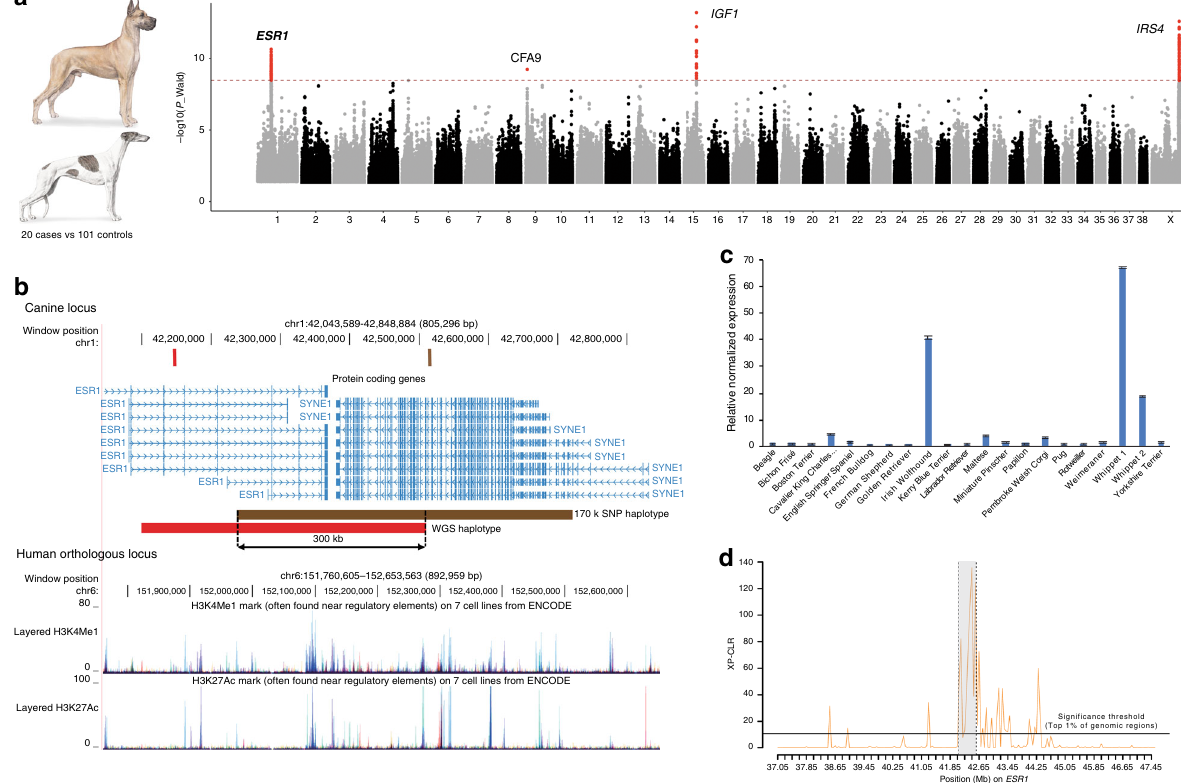
Fig. 4 ESR1 and the long leg phenotype in dogs. a Manhattan plots showing statistical signi fi cance ( − log10 scale) for the 30,000 most associated biallelic variants for each canine autosome, and all variants for the X chromosome ( X -axis) for the long-leg phenotype observed in Sighthounds, Great Dane, and Great Pyrenees. We distinguish four peaks: one peak pinpointing ESR1 gene on chromosome 1, one locus on CFA9 without any candidate genes in the interval, and IGF1 (CFA15) and IRS4 (CFAX) previously associated with height variation in dogs. Images to the left are Great Dane (top) and Greyhound (bottom). b UCSC genome browser showing the ESR1 locus in dog (top) and human (bottom). Vertical bars correspond to the most associated variants identi fi ed with the 722 genomes (in red), and the 855 dogs genotyped on 170k SNP array (in brown), and horizontal bars represent the homozygous haplotype observed. The bottom panel represents the human orthologous locus with tracks corresponding to the H3K4me1 and H3K27ac chromatin signals annotated by the ENCODE project 55 . c Expression level of ESR1 in a panel of 20 breeds, showing high expression in the Sighthounds, Irish Wolfhound and Whippet, in comparison to six different breeds with average leg length. Y -axis represents the relative normalized expression. d XP-CLR plot on ESR1 locus comparing Sighthounds (long legs breeds) with normal-sized legs breeds. We detected a signi fi cant selection signature located on ESR1 locus (in grey). Horizontal lines represent the empirical top 1% of genomic regions. Source data are provided as a Source Data fi